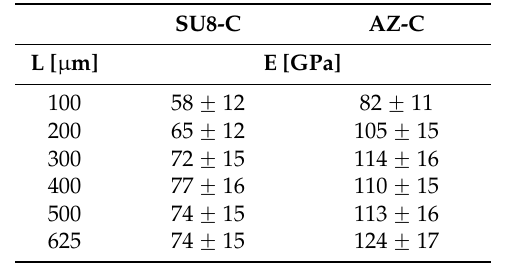
Table 1. Values of Young’s modulus of cantilevers with different length. Errors represent a 95% confidence